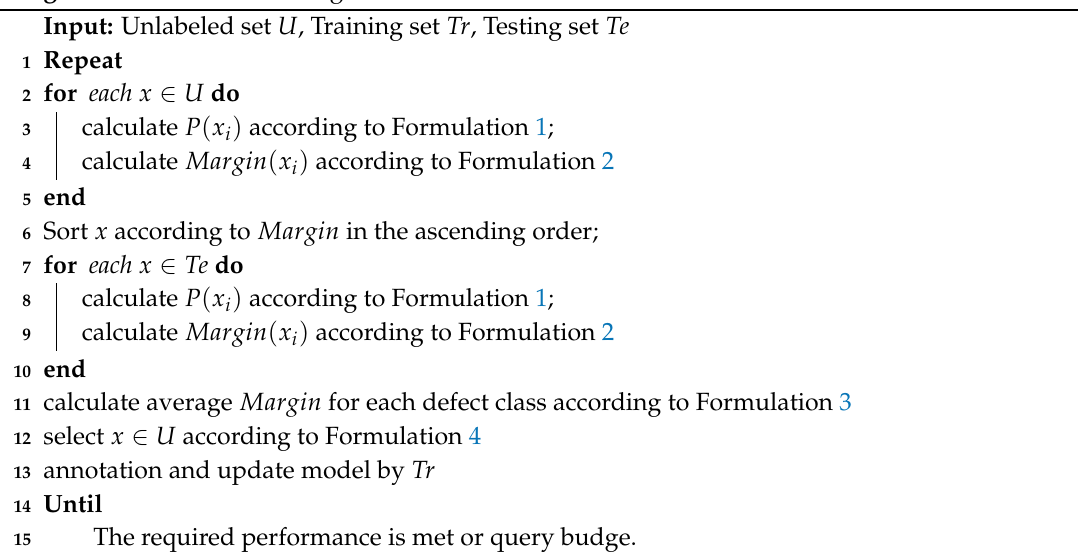
Algorithm 1: Active Learning for Defect